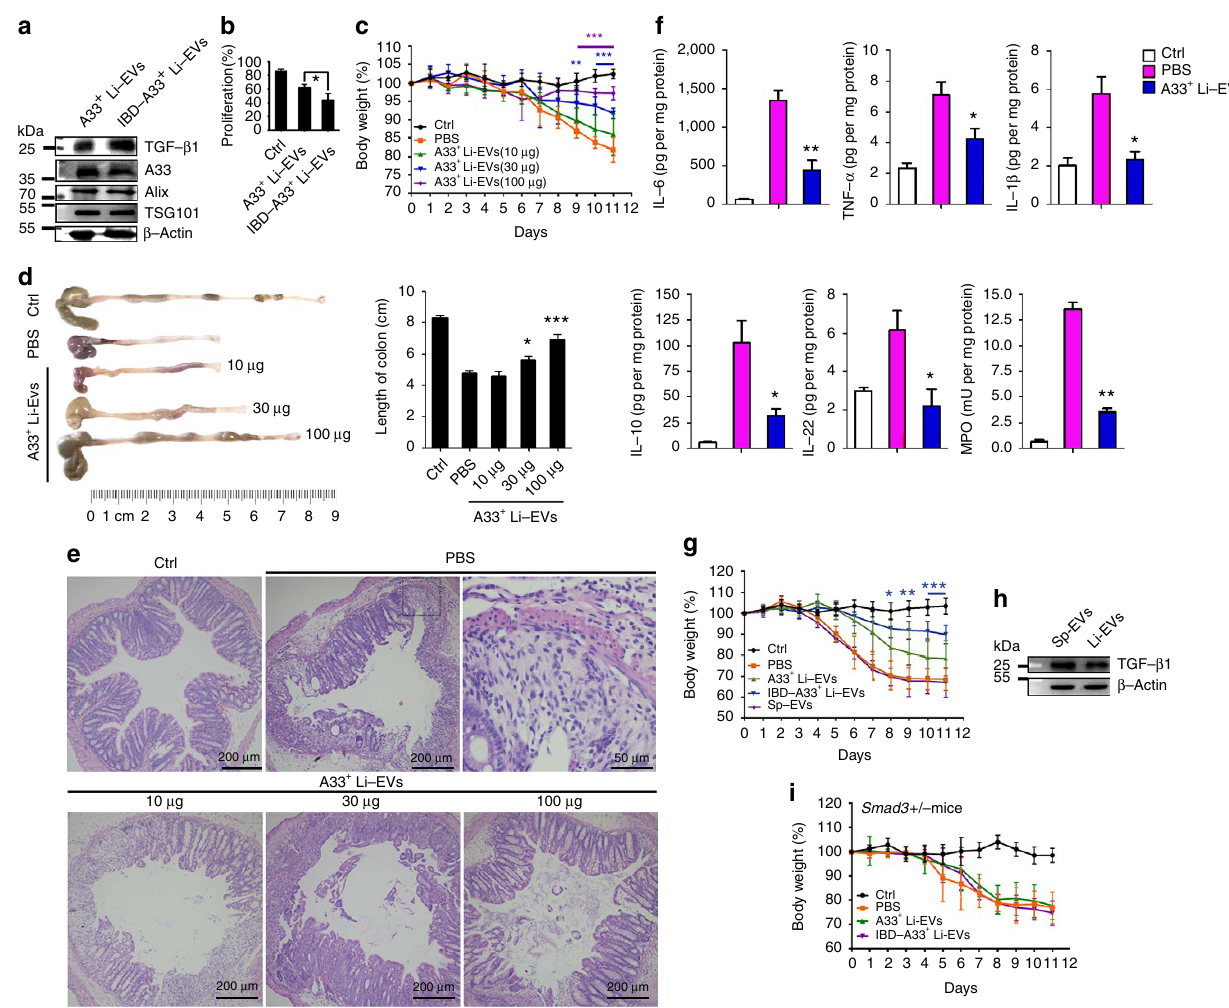
Figure 3 | A33 þ Li-EVs alleviate IBD through TGF- b 1 signalling. ( a ) A33 þ Li-EVs were isolated from healthy control or 2% DSS-induced IBD mice. TGF- b 1, A33 and b -Actin were detected by western blot analysis. ( b ) The CD4 þ T-cell proliferation assay was performed as described above in the presence of 30 m gml (cid:2) 1 Ctrl or IBD-A33 þ Li-EVs, and the results were statistically analysed ( n ¼ 9). ( c – f ) Mice were fed with drinking water containing 2% DSS on day 0. On days (cid:2) 2 and 2, the mice were intravenously treated with the indicated dose of A33 þ Li-EVs. The body weights were measured daily ( c ). Appearance (left) and statistical analysis (right) of colonic length on days 11 ( d ). Histological appearance on day 11. Representative colonic sections stained with haematoxylin and eosine (H&E). In the PBS group, the right image is a magnified region of the left image ( e ). IL-1 b , IL-6, TNF- a , IL-10, IL-22 levels and MPO activity in colon tissue were measured on day 11 ( f ). ( g ) IBD mice were treated with 100 m g A33 þ Li-EVs, IBD-A33 þ Li-EVs and Sp-EVs on days (cid:2) 2 and 2. The body weights were measured daily. ( h ) TGF- b 1 in A33 þ Li-EVs and Sp-EVs was detected using western blot analysis. ( i ) IBD was introduced into Smad3 þ / (cid:2) mice and treated with 100 m g A33 þ Li-EVs and IBD-A33 þ Li-EVs on days (cid:2) 2 and 2. The body weights were measured daily. Ctrl group, mice received normal drinking water; PBS group, mice with drinking water containing 2% DSS and intravenously treated with PBS on days (cid:2) 2 and 2. ( a , b , d – f ) Data are representative of three independent experiments or shown as mean values ± s.e.m. pooled from three independent experiments; ( c , g , i ) data are presented as the mean ± s.d. from one of the three independent experiments ( n ¼ 5 per group). P values were generated by one-way ANOVA in b , d , f , or two-way ANOVA in c , g , i , followed by Newman–Keuls multiple comparison test using GraphPad Prism 5 (* P o 0.05, ** P o 0.01, *** P o 0.001), corresponding colour indicating the relevant group versus PBS group in c , versus PBS group in d , f ; IBD-A33 þ Li-EVs versus A33 þ Li-EVs in g